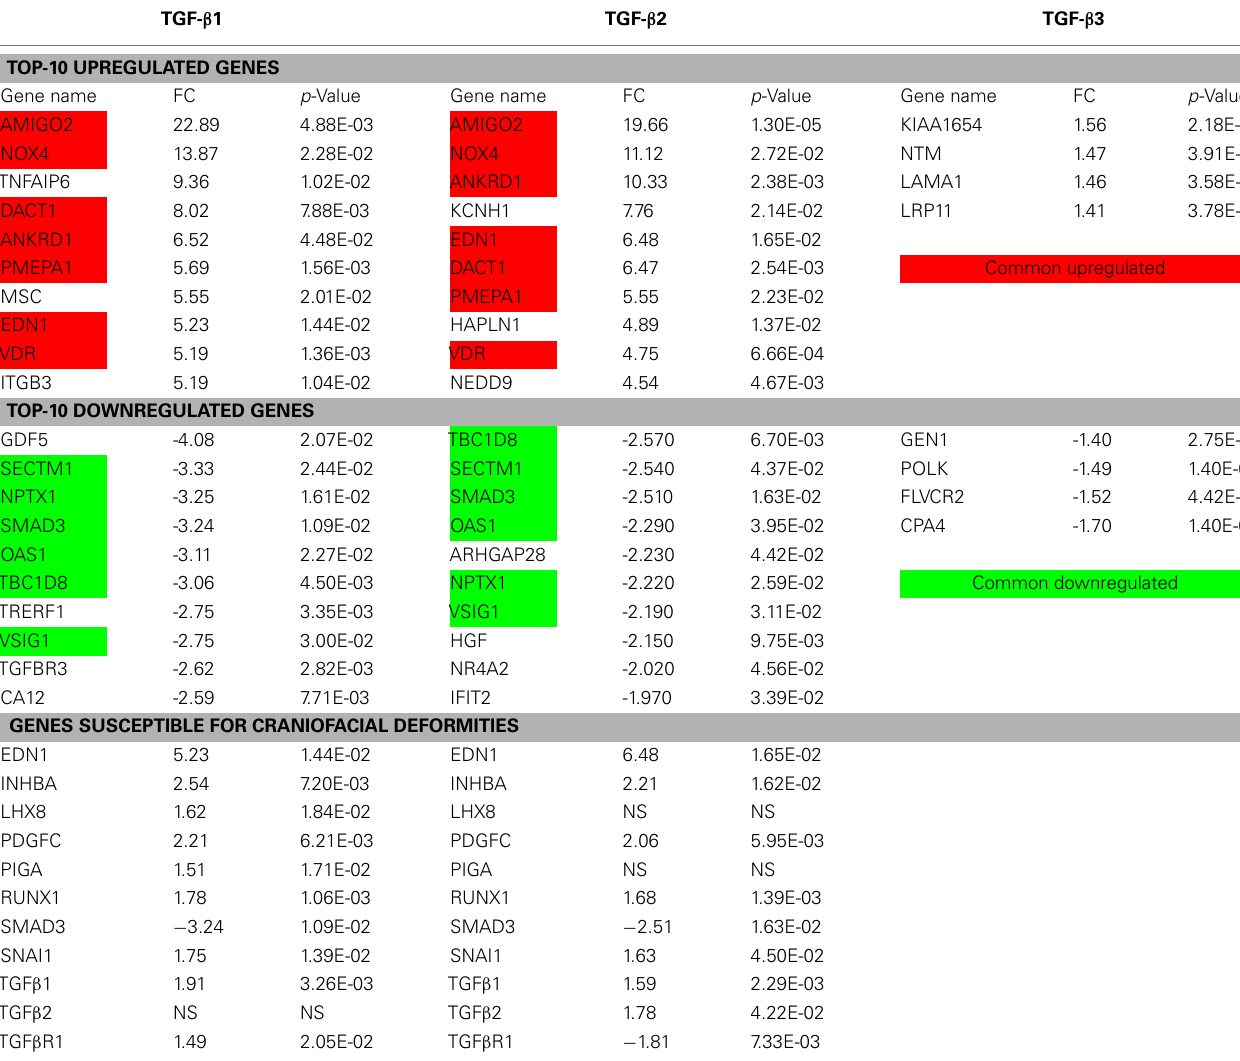
Table 2 |The most significantly altered genes within the palatal mesenchyme withTGF β treatment. TGF- β